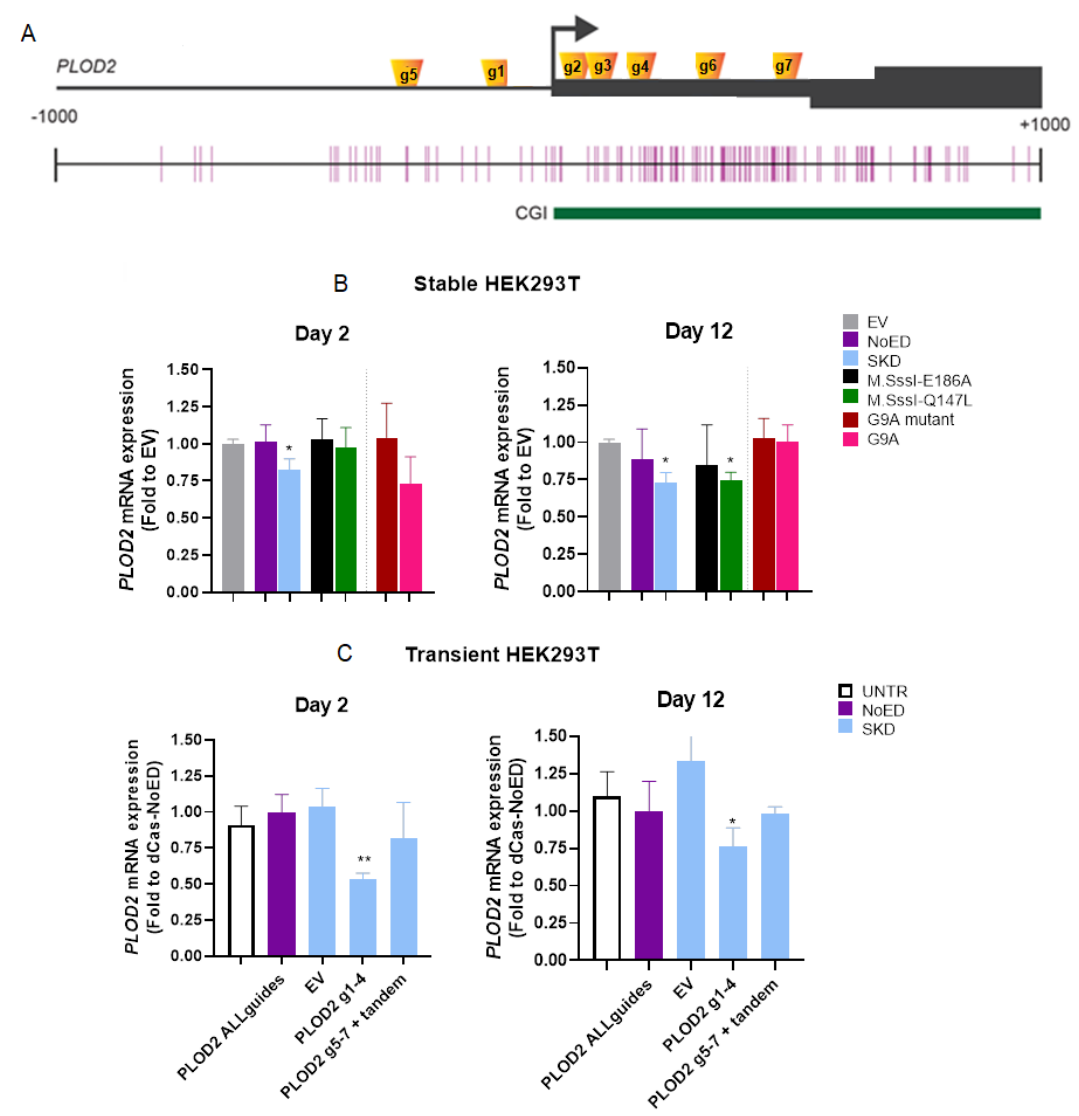
Figure 8. Sustained repression of PLOD2 by SKD targeted to the PLOD2 promoter by CRISPR-dCas9 in HEK293T cells. ( A ) Schematic representation of the PLOD2 locus with binding locations of the sgRNAs (g1-7). ( B ) PLOD2 mRNA expression levels in HEK293T cells constitutively expressing the indicated dCas-fusions, 2 and 12 days after transient transfection with sgRNA g1-4 plasmids. Data are shown relative to the PLOD2 expression in the respective transgenic cells upon transfection with plasmids expressing “empty” guide RNA vector (EV), set at one for each stable cell line. ( C ) PLOD2 mRNA expression levels of wild-type HEK293T cells, 2 and 12 days after transient transfection with plasmids encoding the indicated sgRNAs and dCas9-SKD (blue bars). Data are shown relative to PLOD2 expression in cells transfected with plasmids expressing all gRNAs and dCas9-NoED (No E ff ector Domain), set as 1 (purple bar). EV (empty vector) refers to sgRNA plasmids without the targeting nucleotides. Data are the mean ± SEM of biological triplicates, di ff erences are analyzed using unpaired two-tailed Student’s t -test vs. EV ( B ) or vs. dCas9-NoED ( C ); * p < 0.05, ** p < 0.01.